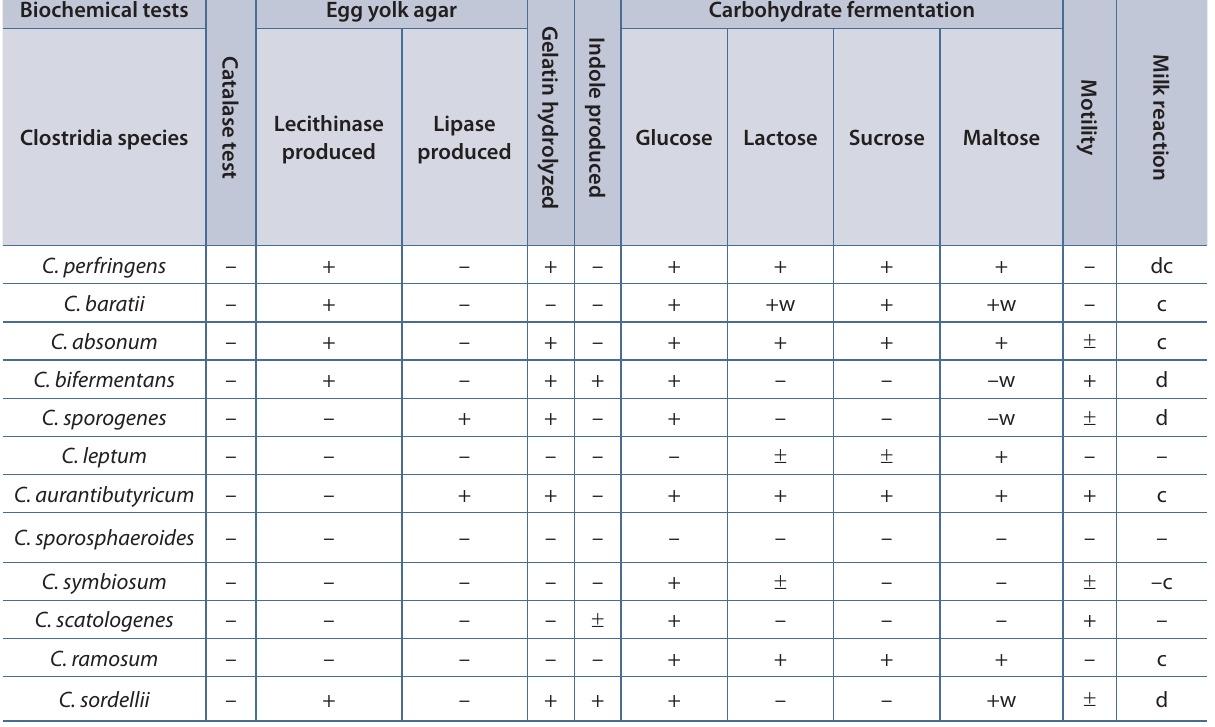
Table 1. Biochemical tests for identification some clostridia species Biochemical